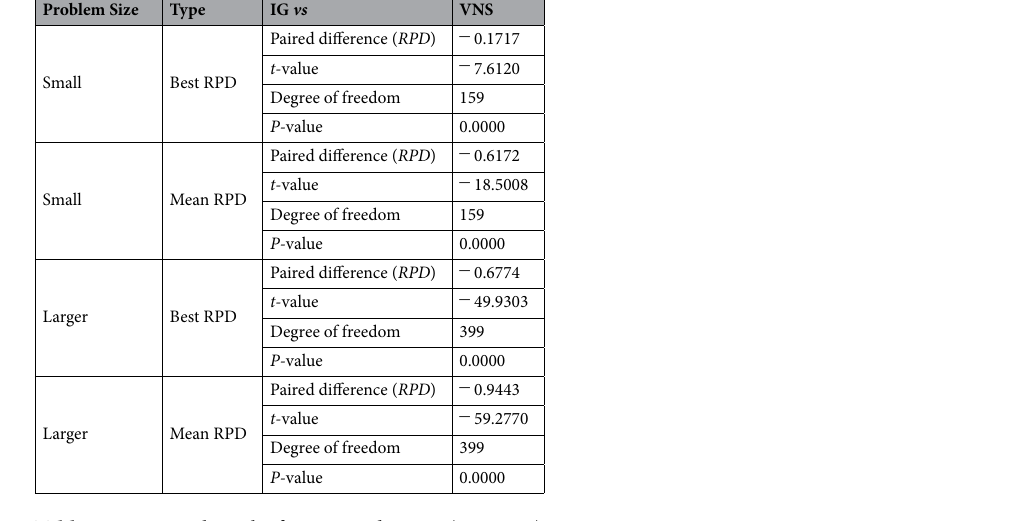
Table 9. Statistical results from paired- t tests ( α =